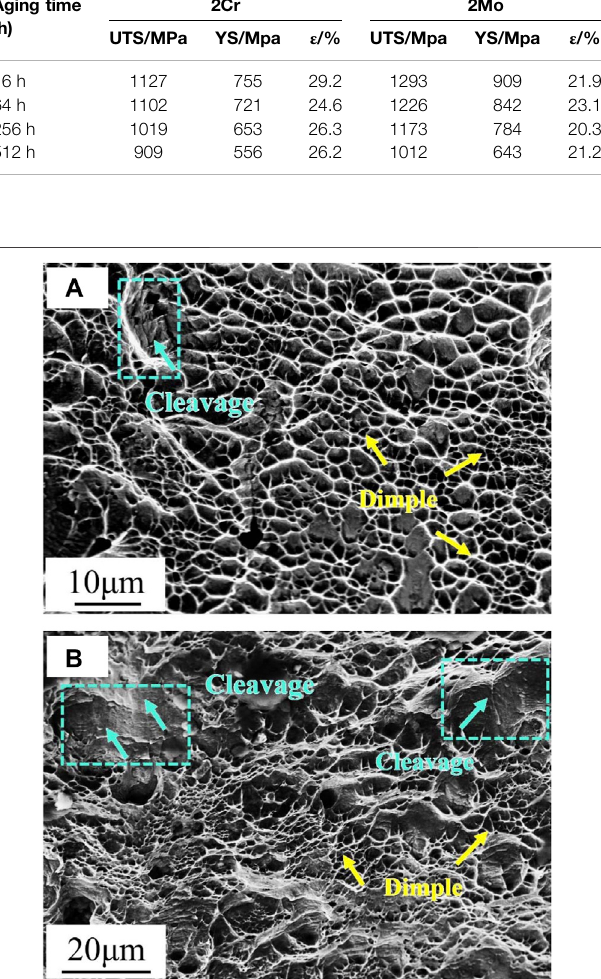
FIGURE7| Tensilefracturesurfacesofsuperalloysatroomtemperature after being aged for 64 h at 1073 K: (A) 2Cr, (B)